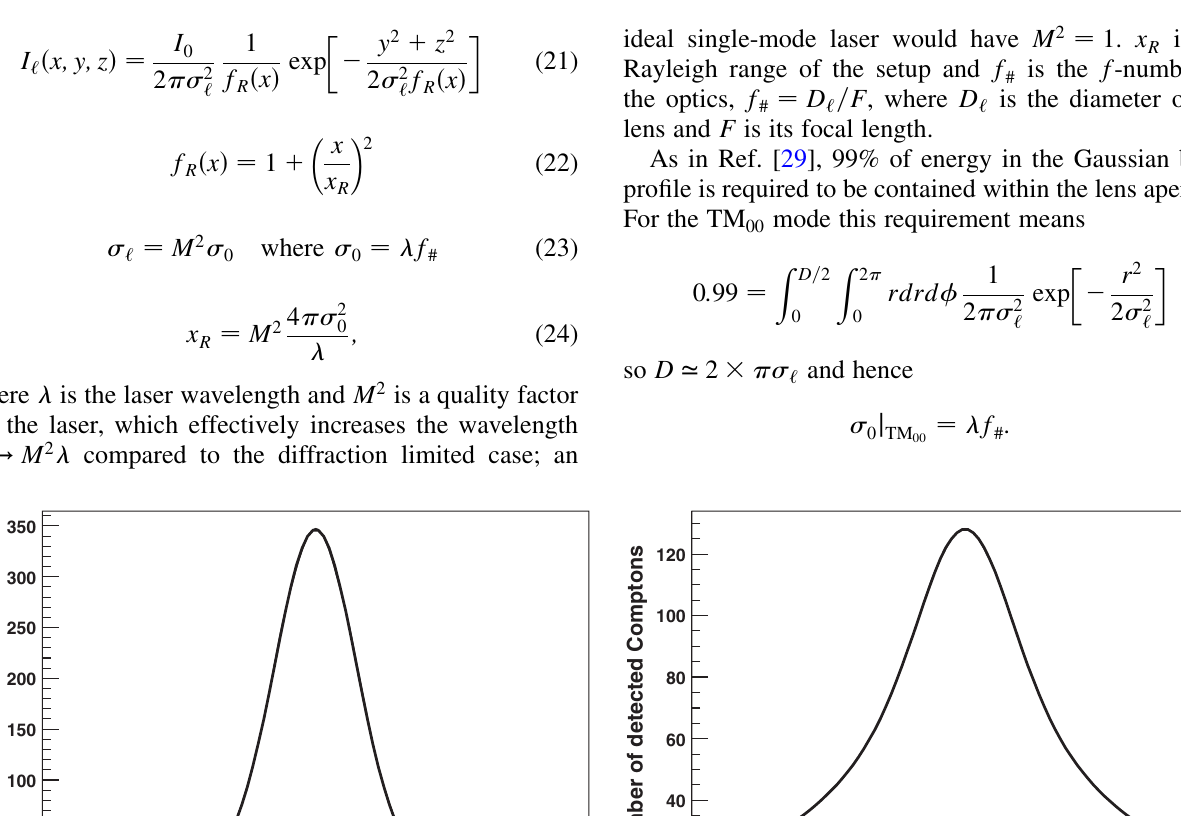
FIG. 13. Scan profile at the laser-wire IP for a laser with M 2 (cid:1) 1 : 3 and wavelength 532 nm operating in the TM optics. The electron bunch is assumed to have a Gaussian profile. (a) (cid:2) using f 1 50 (cid:3) m